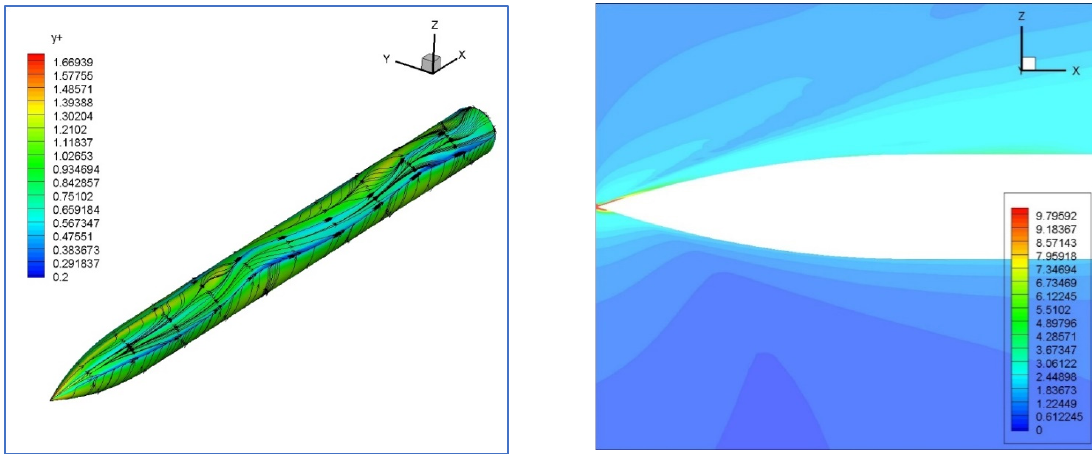
Figure 4. Left: y+ contours and skin friction lines. Right: CFL contours in the tip region with Δ t = 5 × 10 − 4 s: Transversal plane y = 0. Ma = 0.2, Reynolds number Re = 2 × 10 6 and angle of attack α = 45 degrees. Reference structured grid.